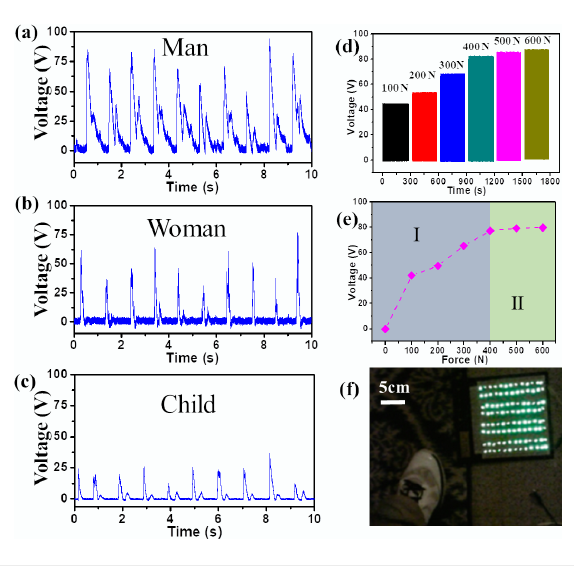
Figure 4: The ability of the u-TENG to harvesting energy from human walking. The electric output profile of a man (a), a woman (b), and a child (c). (d) The output voltage of u-TENG under different stress values. (e) The dependence of the output voltage on the impact force. (f) 110 LED bulbs are lit by stepping on a